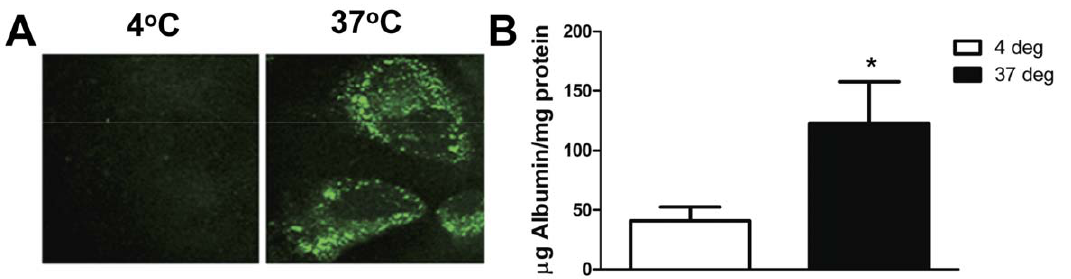
Figure 1. Cultured human podocytes endocytose albumin. A , Confocal image of cultured human podocytes placed at 4 u C (inhibits endocytosis) or 37 u C (promotes endocytosis) and treated with 1.5 mg/ml human FITC-albumin. Bright green vesicles seen in the podocytes at 37 u C are FITC-albumin containing endosomes. B, Podocytes were treated with 1.5 mg/ml FITC-albumin at 4 u C or 37 u C for 2 hrs. There is a significant increase in the amount of albumin taken up by podocytes at 37 u C compared to those at 4 u C. * denotes P=0.01 compared to albumin uptake at 4 u C.